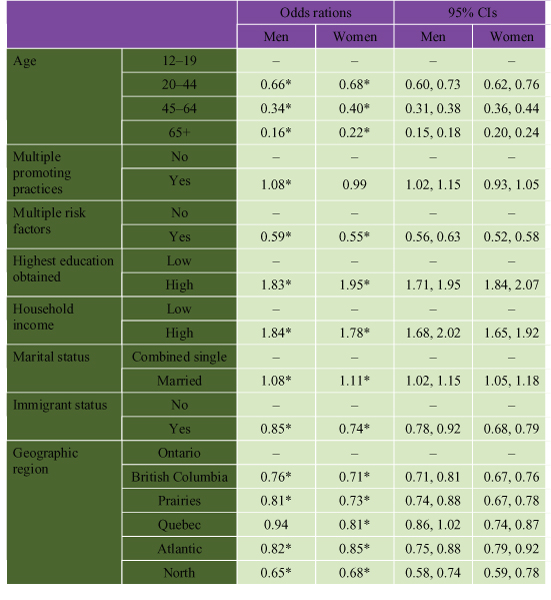
Odds Of Reporting Excellent or Very Good Health Controlling for Multiple Health-Promoting Practices,1 Multiple Health Risk Factors2 and Other Selected Demographic Factors. Source: Statistics Canada, CCHS, 2000–2001.1 Multiple health promoting practices is defined as having two or more of the following health promoting behaviours: being physically active, consulting an alternative health care provider, doing something in previous 12 months to improve health, consuming fruits and   vegetables more than 5 times/serving per day.  2 Multiple health risk is defined as having two or more of the following health risk factors: smoking, using pain relievers, binge drinking, being physically inactive, consuming fruits and vegetables fewer than 5 times/serving per day.  *  All results were from Statistics Canada bootstrap program